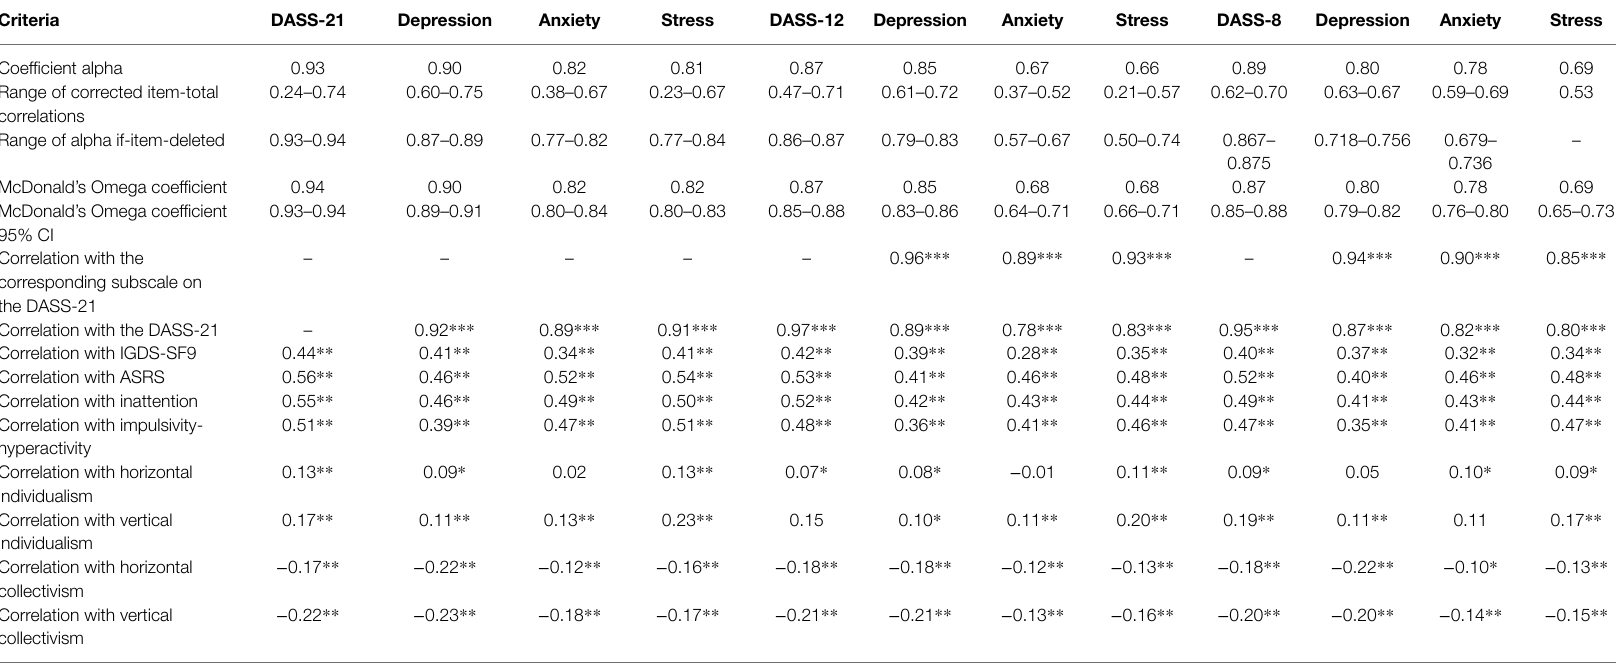
TABLE 5 | Internal consistency and criterion validity of the Depression Anxiety Stress Scale (DASS) 21, DASS-12, DASS-8, and their subscales among the participants. Criteria DASS-21 Depression Anxiety Stress